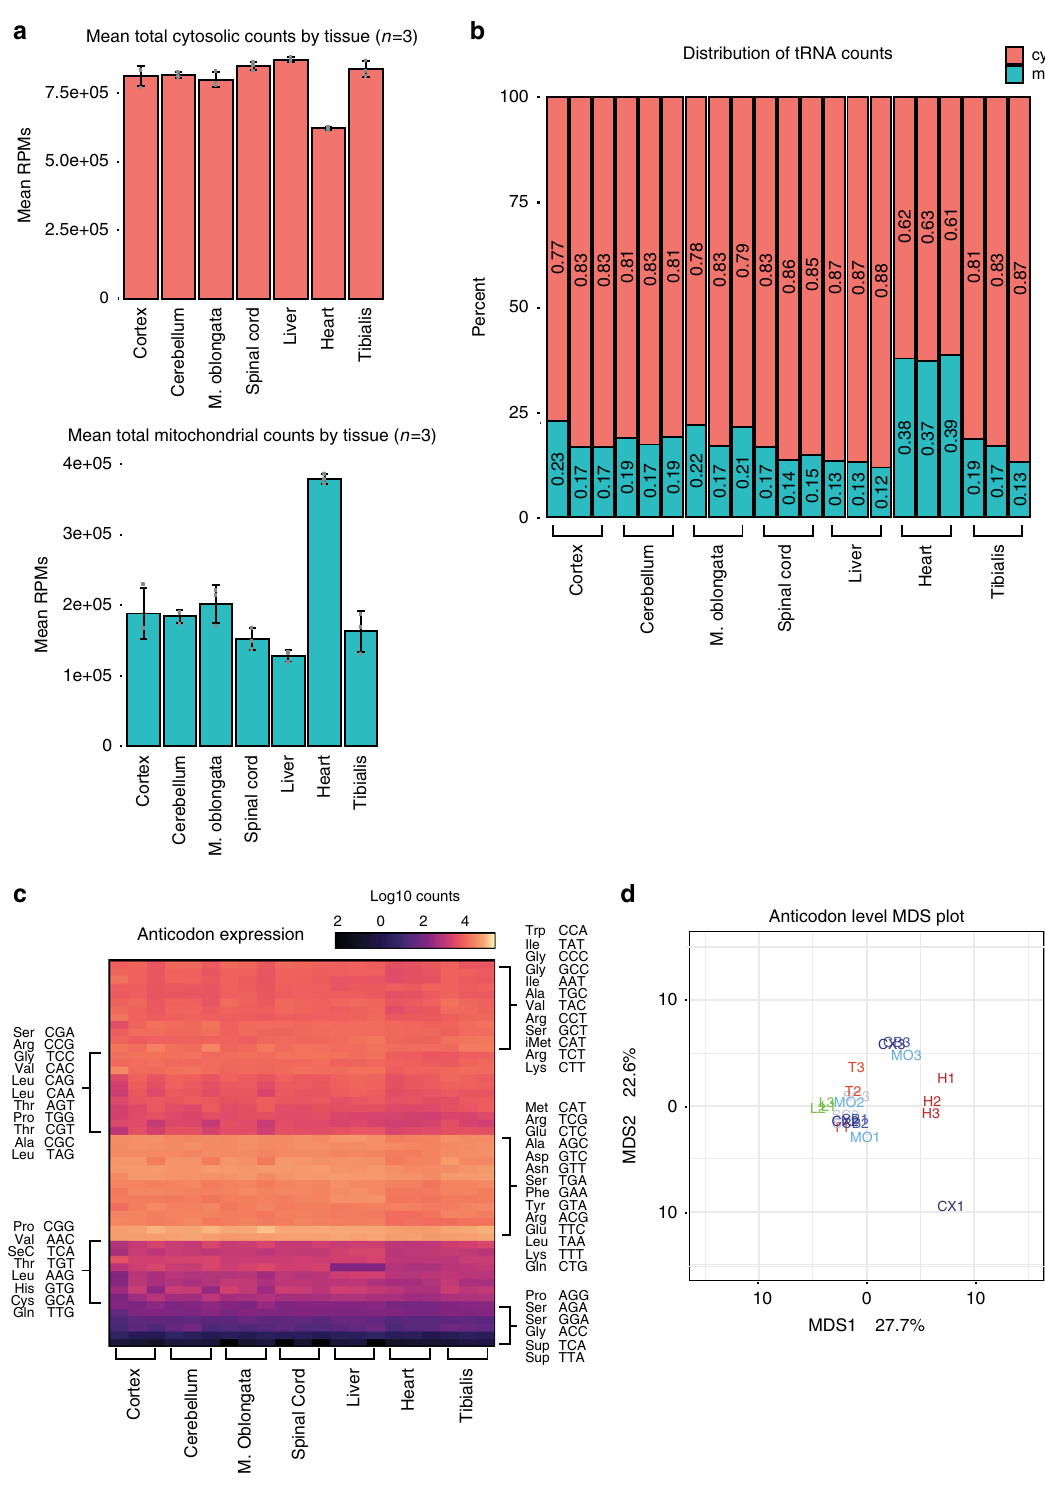
Fig. 3 tRNA anticodon pools are similar across mouse tissues. a Bar chart with center showing the mean cytosolic tRNA reads per million (top) and mitochondrial tRNA reads per million (bottom) across seven mouse tissues. Error bars represent the standard deviation of N = 3 biological replicates. b Stacked bar charts showing the percentage of reads from each library that correspond to either cytoplasmic tRNA or mitochondrial tRNA. c tRNA reads were collapsed by known anticodon groups, log 10 transformed, and then plotted as a heatmap. d Table used to generate ( c ) was used to create a multidimensional scaling plot to examine the distance between tissues with regards to tRNA expression at the anticodon level (Euclidean Distance). CNS tissues are labeled in shades of blue, non-CNS muscle tissues are in red, and the non-CNS liver is in